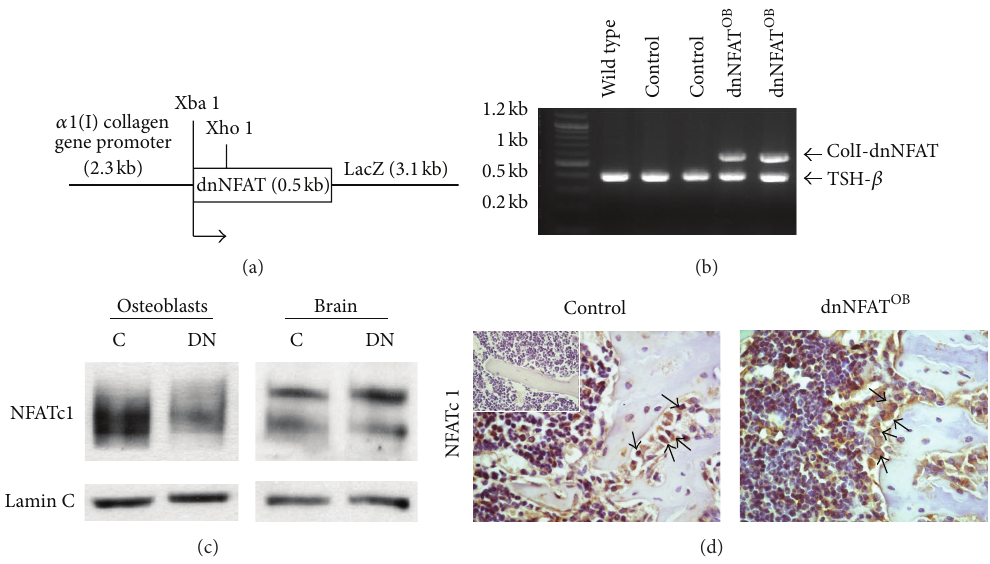
Figure 1: Generation of dnNFAT OB mice. (a) Representation of ColI-dnNFAT transgene construct. (b) DNA was extracted from tail biopsies and amplified by PCR for a 0.55 kb fragment of the ColI-dnNFAT transgene. Mice without ColI-dnNFAT were used as controls. The amplification of thyroid stimulating hormone-beta (TSH- 𝛽 ) was used as a loading control. (c) Primary osteoblasts were harvested from calvariae of 1-day-old mice and differentiated 7–14 days. Brain tissue was removed from 12-week-old mice and homogenized. Nuclear proteins were used for immunoblotting with antibodies against NFATc1 and lamin C. Immunoblots are representative of three independent experiments ( 𝑛 = 3 ). (C = control; DN = dnNFAT OB . ) (d) Femora were harvested from 12-week-old control ( 𝑛 = 3 ) and dnNFAT OB ( 𝑛 = 3 ) mice and examined by immunohistochemistry with anti-NFATc1 ( brown ), counterstained with hematoxylin ( blue ). Negative control staining was performed by using normal rabbit IgG instead of primary antibody ( left panel inset ). Magnification,